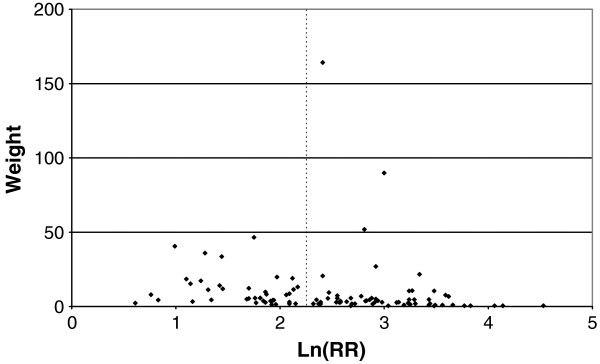
Funnel plot for ever smoking and squamous. Funnel plot of the 102 relative risk estimates for ever smoking and squamous included in the main meta-analysis in Table
5 against their weight (inverse-variance of log RR). The dotted vertical line indicates the fixed-effect meta-analysis estimate.